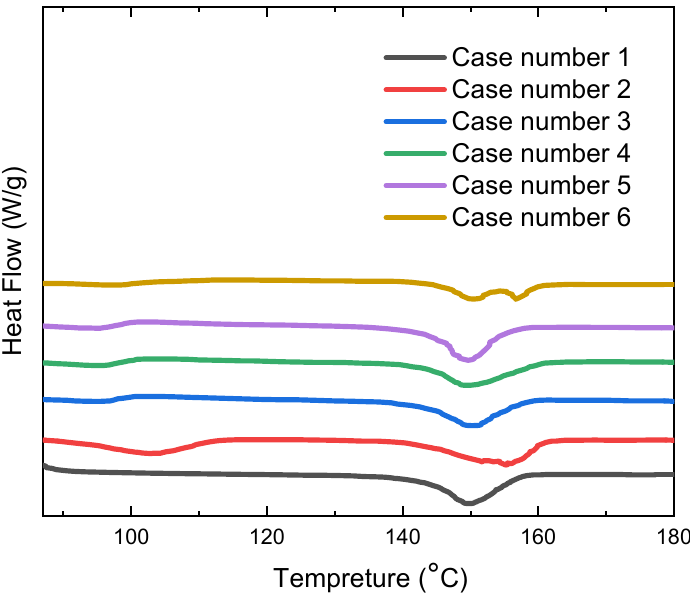
Figure 4. DSC thermograms of P(VDF-TrFE) nanofibers.